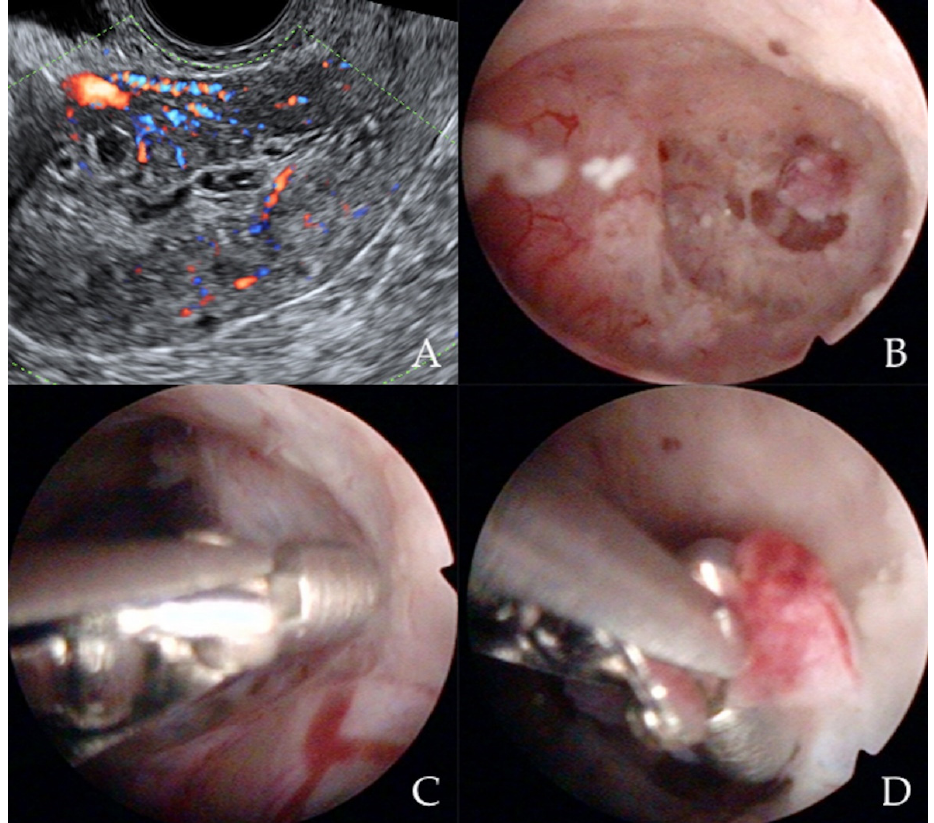
Figure 3 . Ultrasonographic appearance of uterine lesion suspected for early-stage endometrial cancer ( A ). The diagnostic hysteroscopic allows for visualizing the suspected uterine area ( B ) and for obtaining the histologic biopsy ( C , D ). Intraoperative photographs by F.B. and S.F. Less threatening but a more common finding in patients with AUB (20–31% of cases) are endometrial polyps [9–11,25,33]. The sensitivity of TVS for the diagnosis of polyps is particularly low (0.51) [25]. In contrast, in women with postmenopausal AUB, the sensitivity and specificity of hysteroscopy for the diagnosis of polyps are reported at 0.81–0.92 and 0.85–0.98, respectively [11,26]. The study by de Godoy Borges et al. [23] confirmed the superiority of diagnostic hysteroscopy (96.4% sensitivity, 74.6% specificity) in comparison to TVS (88.7% sensitivity, 25.4% specificity) for detecting endometrial polyps in women aged 41 to 82 presenting with AUB. Saline Infusion Sonohysterogram (SIS) provides a similar sensitivity compared with hysteroscopy but lower specificity (0.93